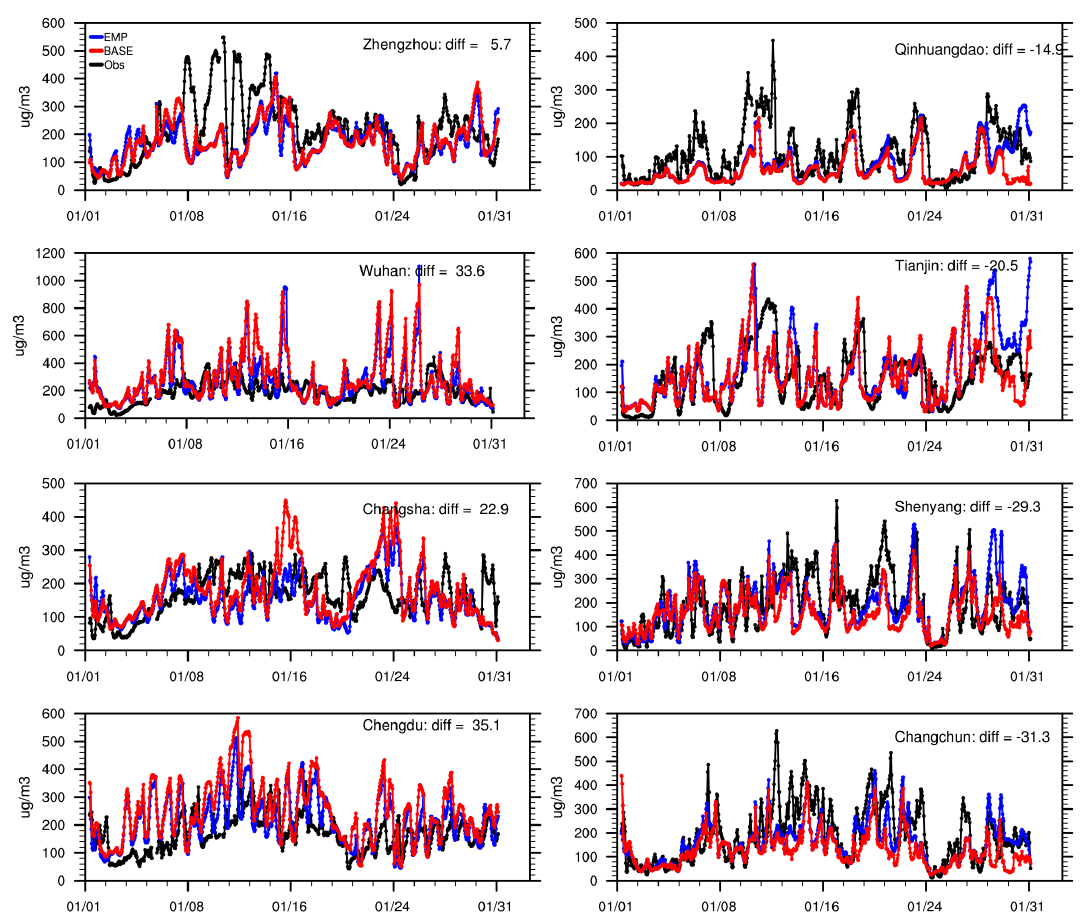
Figure 11. Time series of observed (black) and simulated (red for BASE scenario and blue for EMP scenario) hourly surface PM 2 . 5 mass concentrations in eight cities for January 2013. Monthly mean PM 2 . 5 is enhanced in the four cities (Zhengzhou, Wuhan, Changsha, and Chengdu) in the left column. Cities in the right column have suppressed monthly mean PM 2 . 5 mass concentrations. “Diff” indicates aerosol feedbacks (BASE − EMP) on monthly mean PM 2 . 5 mass